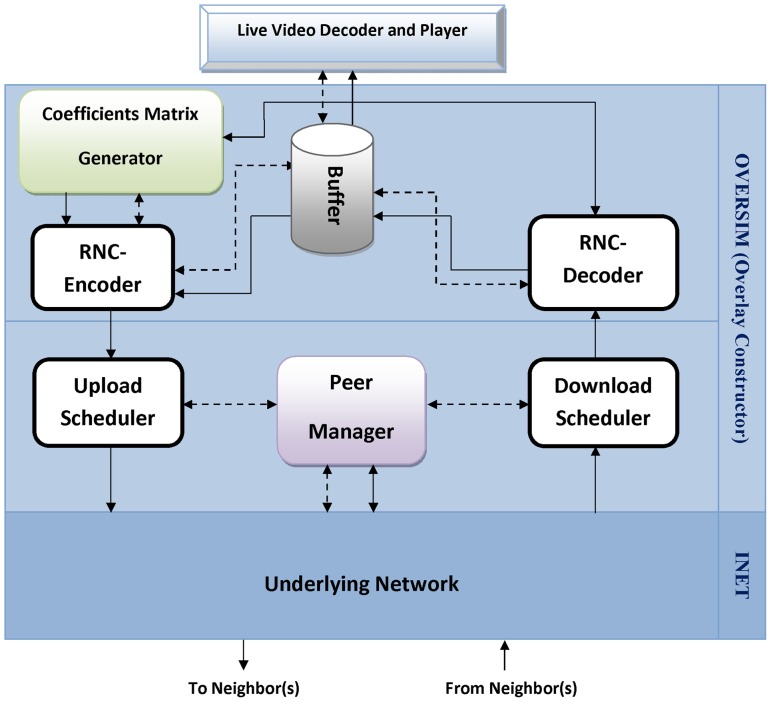
The MATIN Framework.